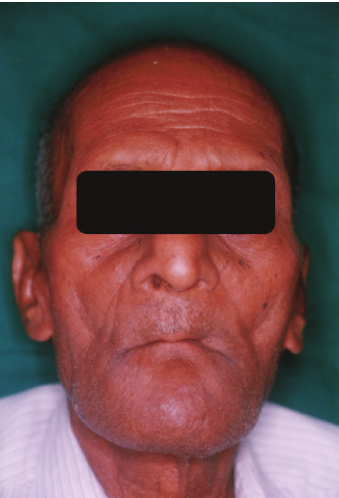
Figure 1: Completely edentulous Parkinson patient with mask-like face and fixed gaze.